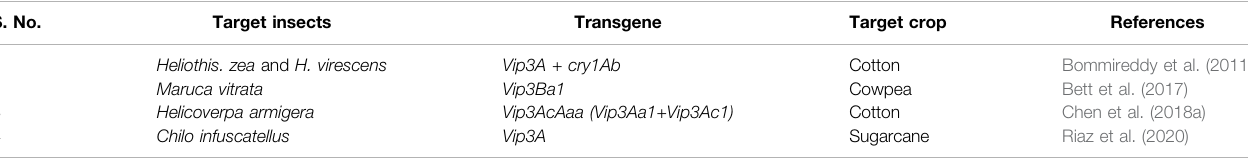
TABLE 2 | Expression of VIP genes for insect resistance. S.